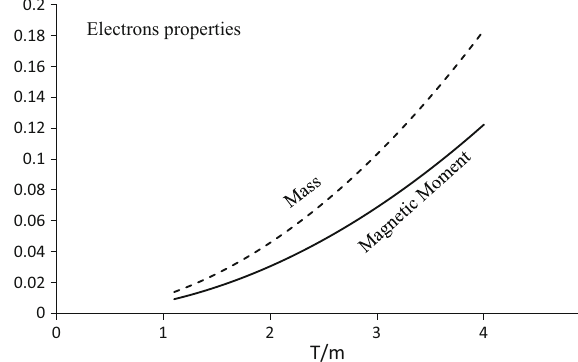
Fig. 3 A comparison of temperature dependent self-mass and the cor- responding magnetic moment of the electron shows that the behavior of magnetic dipole moment at finite temperature is exactly similar to the mass of the electron at high temperatures, i.e; T > m